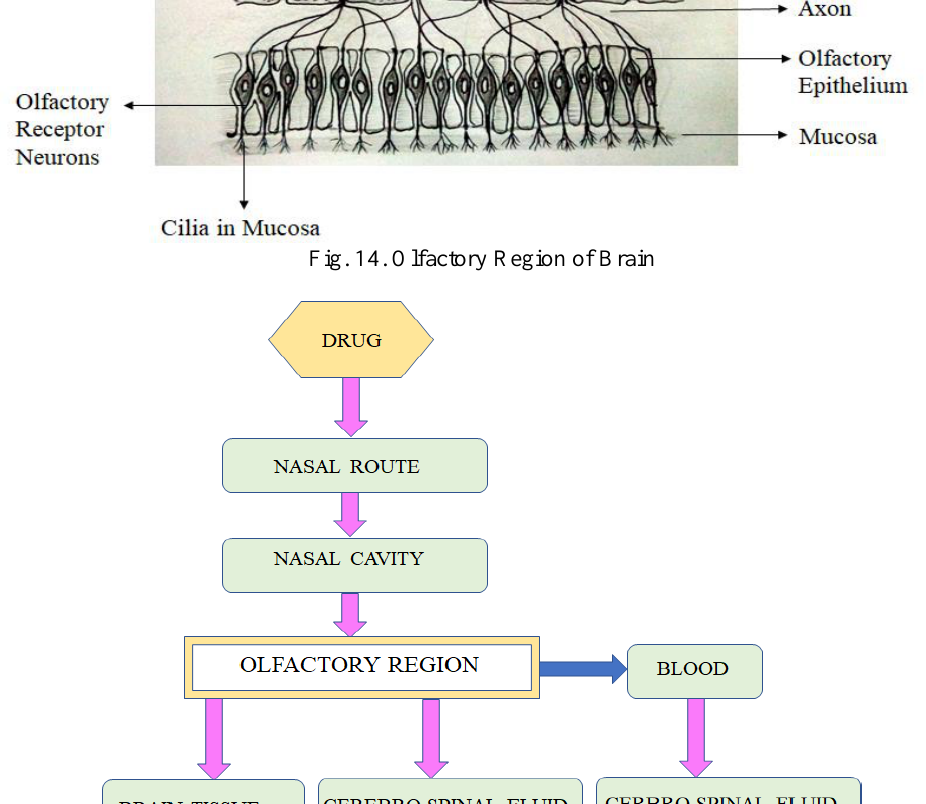
Fig. 15. Schematic representation of intranasal drug